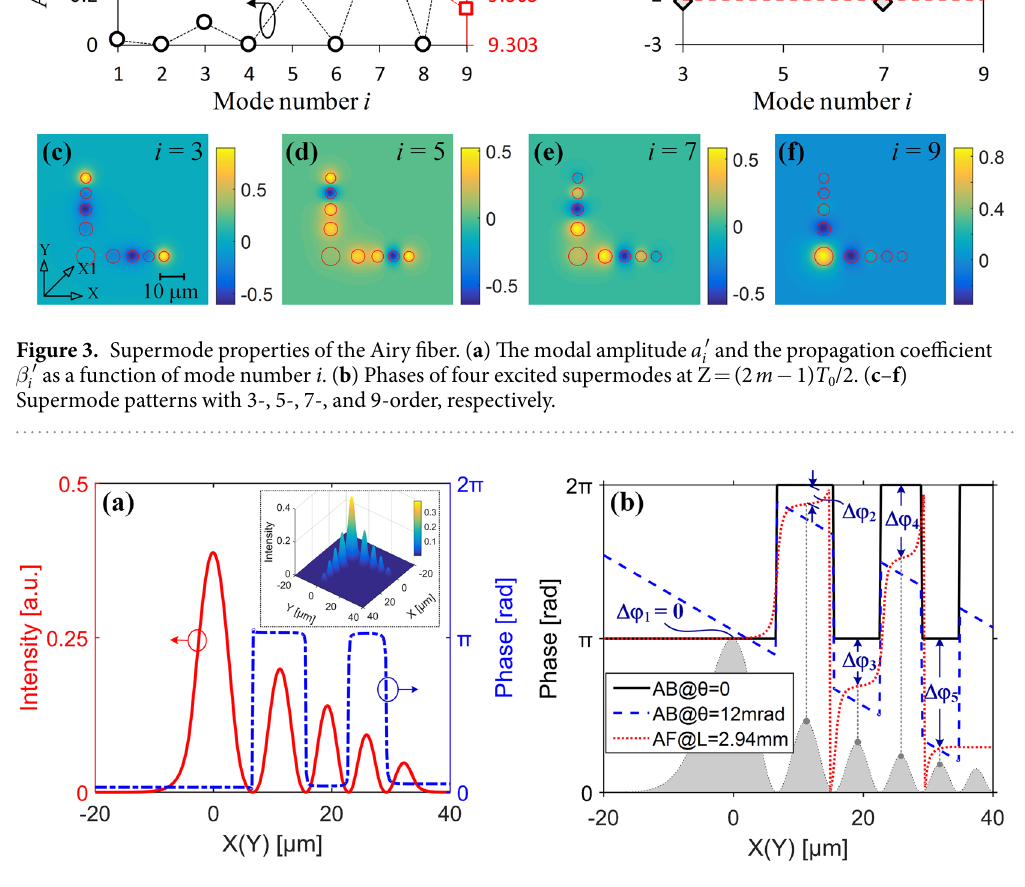
Figure 4. The properties of the output beam from the Airy fiber. ( a ) The intensity and phase distributions of the output beam from Z D = 2.2 mm ( T 0 /2) length of the Airy fiber. The solid line and the dash-dot line depict intensity and phase distributions in arrayed cores along the x-axis or the y-axis, respectively. The inset is corresponding transverse intensity pattern.( b ) The phase curves of the output beam from Z E ≈ 2.94 mm ( T 0 /2 + T 0 /6) length of Airy fiber (dot line) and the ideal Airy beams with launch angles θ = 0 (solid line) and θ = 12 mrad (dash line). The shaded area in ( b ) is corresponding to the optical intensity profile of the ideal Airy beam with launch angles θ =